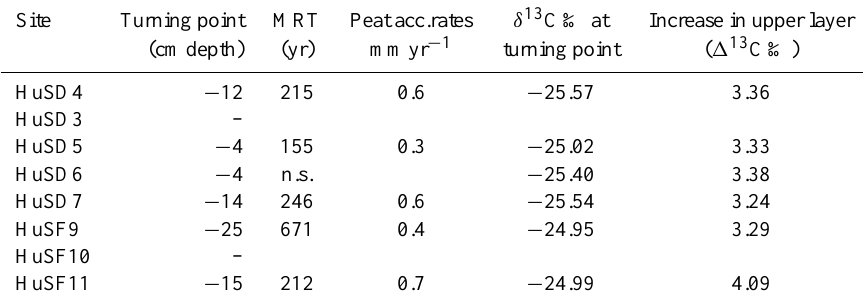
Table 2. Turning points, C 14 ages at turning point as mean residence time in years (MRT), peat accumulation rates per year, stable carbon isotope value of the turning point and the increase in stable carbon isotopes in the upper layer ( 1 13 C). n.s.=Harkness et al. (1986) model